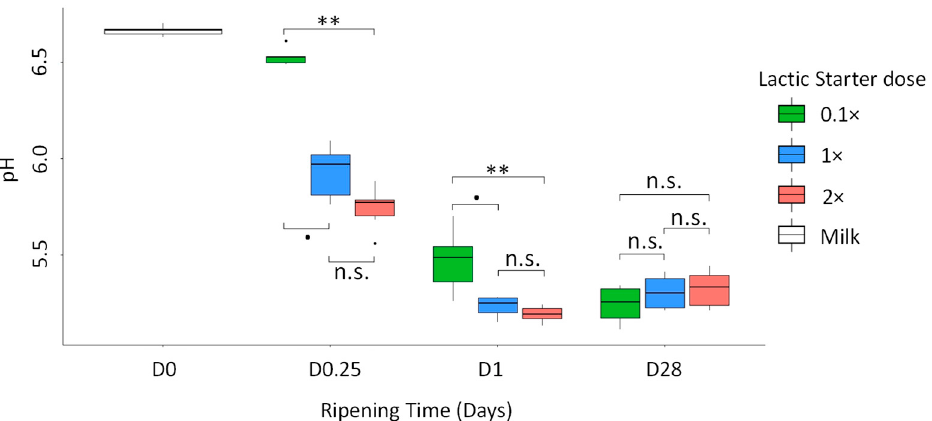
Figure 3. pH values in milk (D0) and in cheeses at D0.25, D1 and D28, according to the lactic starter dose ( n = 6). The differences according to the dose were estimated by a multiple comparison test, a Dunn’s test. ** p < 0.01; • tendency; n.s. non-significant. For milk samples ( n = 6), no statistical tests were performed.